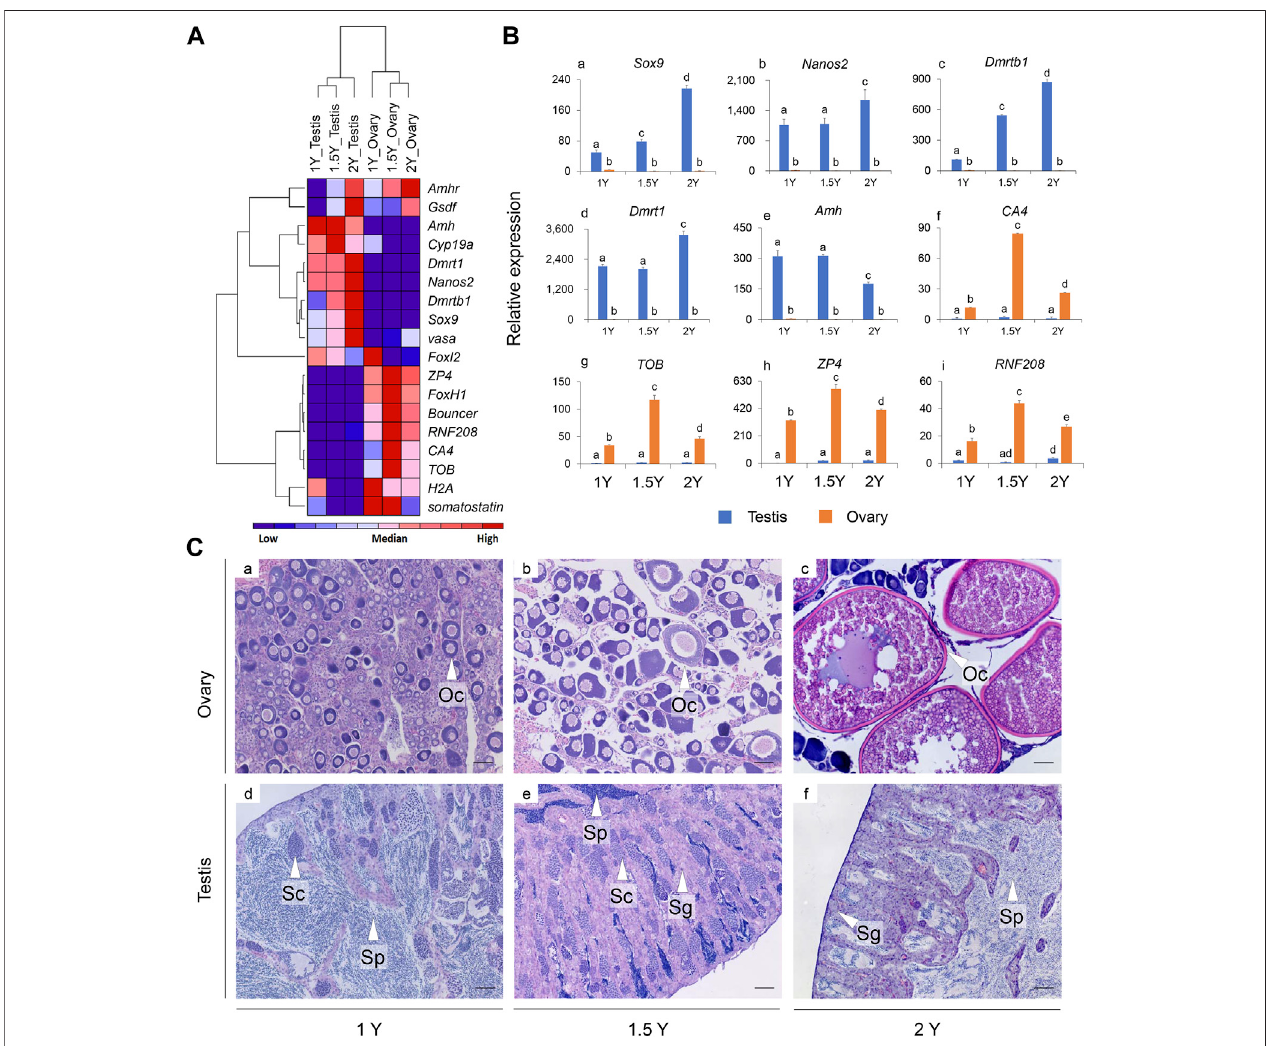
FIGURE 5 | The expression patterns of selected genes in the gonads and the histological observation of the gonads for the rock breams at different development stages(1,1.5,and2Y). (A) Heatmapoftheexpressionpatternsfor18selectedgenes;Redindicatesrelativehighexpression,blueindicatesrelativelowexpression,and color depth indicates relative expression levels; (B) Detailed expression patterns of selected genes (the histograms for the rest nine genes were shown in SupplementaryFigureS12 ). (C) Histologicalobservationofthegonadsatdifferentdevelopmentstages.Scalebars (cid:1) 50 μ m.Y,yearold;Oc,oocyte;Sp,sperm; Sc, spermatocyte; Sg,